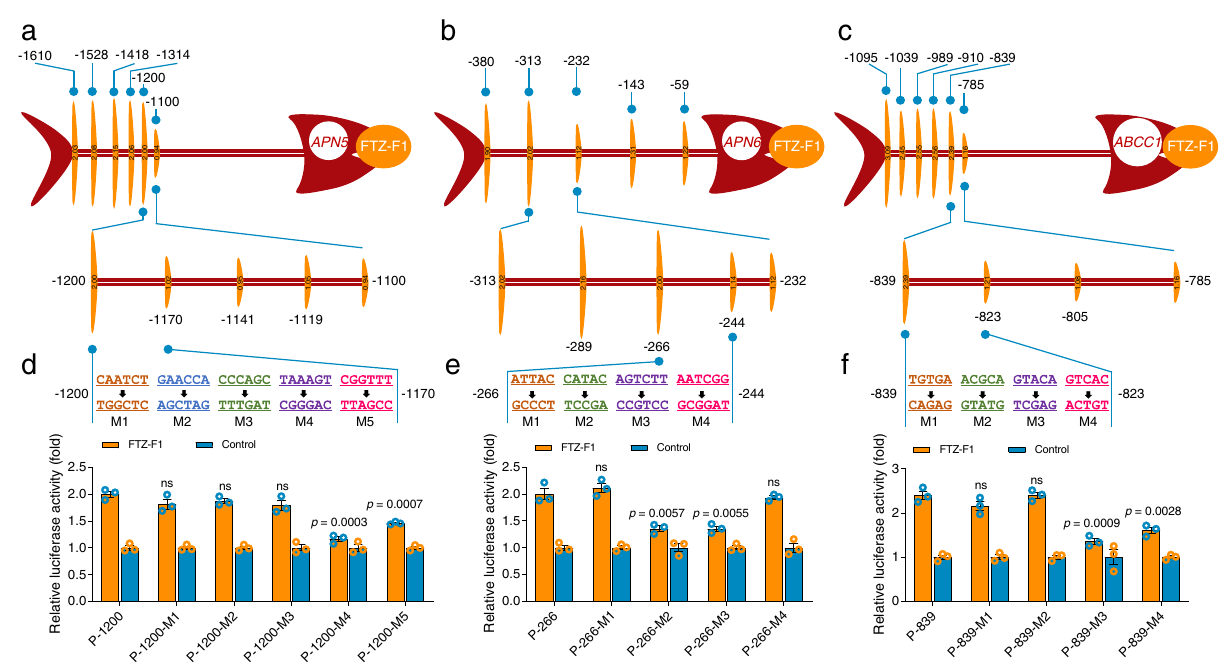
Fig. 2 | Preliminary identi fi cation of the functional binding sites in the pro- moters of the non-receptor genes APN5 , APN6 , and ABCC1 by a dual-luciferase reporter assay. The FTZ-F1 expression vector was co-transfected with various truncatedpromotersofnon-receptorgenes APN5 ( a ), APN6 ( b ),and ABCC1 ( c ).The results are presented using the same fi sh-likestructure as Fig. 1. The lower “ bones ” represent the second set of deletions created within the region identi fi ed as con- taining the functional binding site from the initial set of deletions. The horizontal numbers represent the nucleotide position of the different truncations relative to the start codon. d – f The effect of FTZ-F1 on wild-type or mutated promoters of